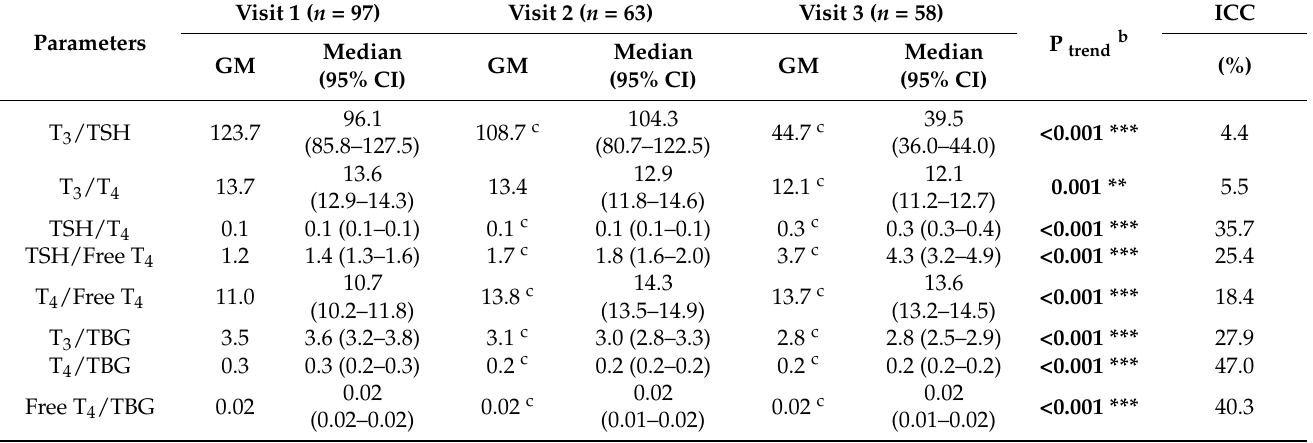
Table 3. Distribution of thyroid hormone ratios in pregnant women by study visits (N =218) a